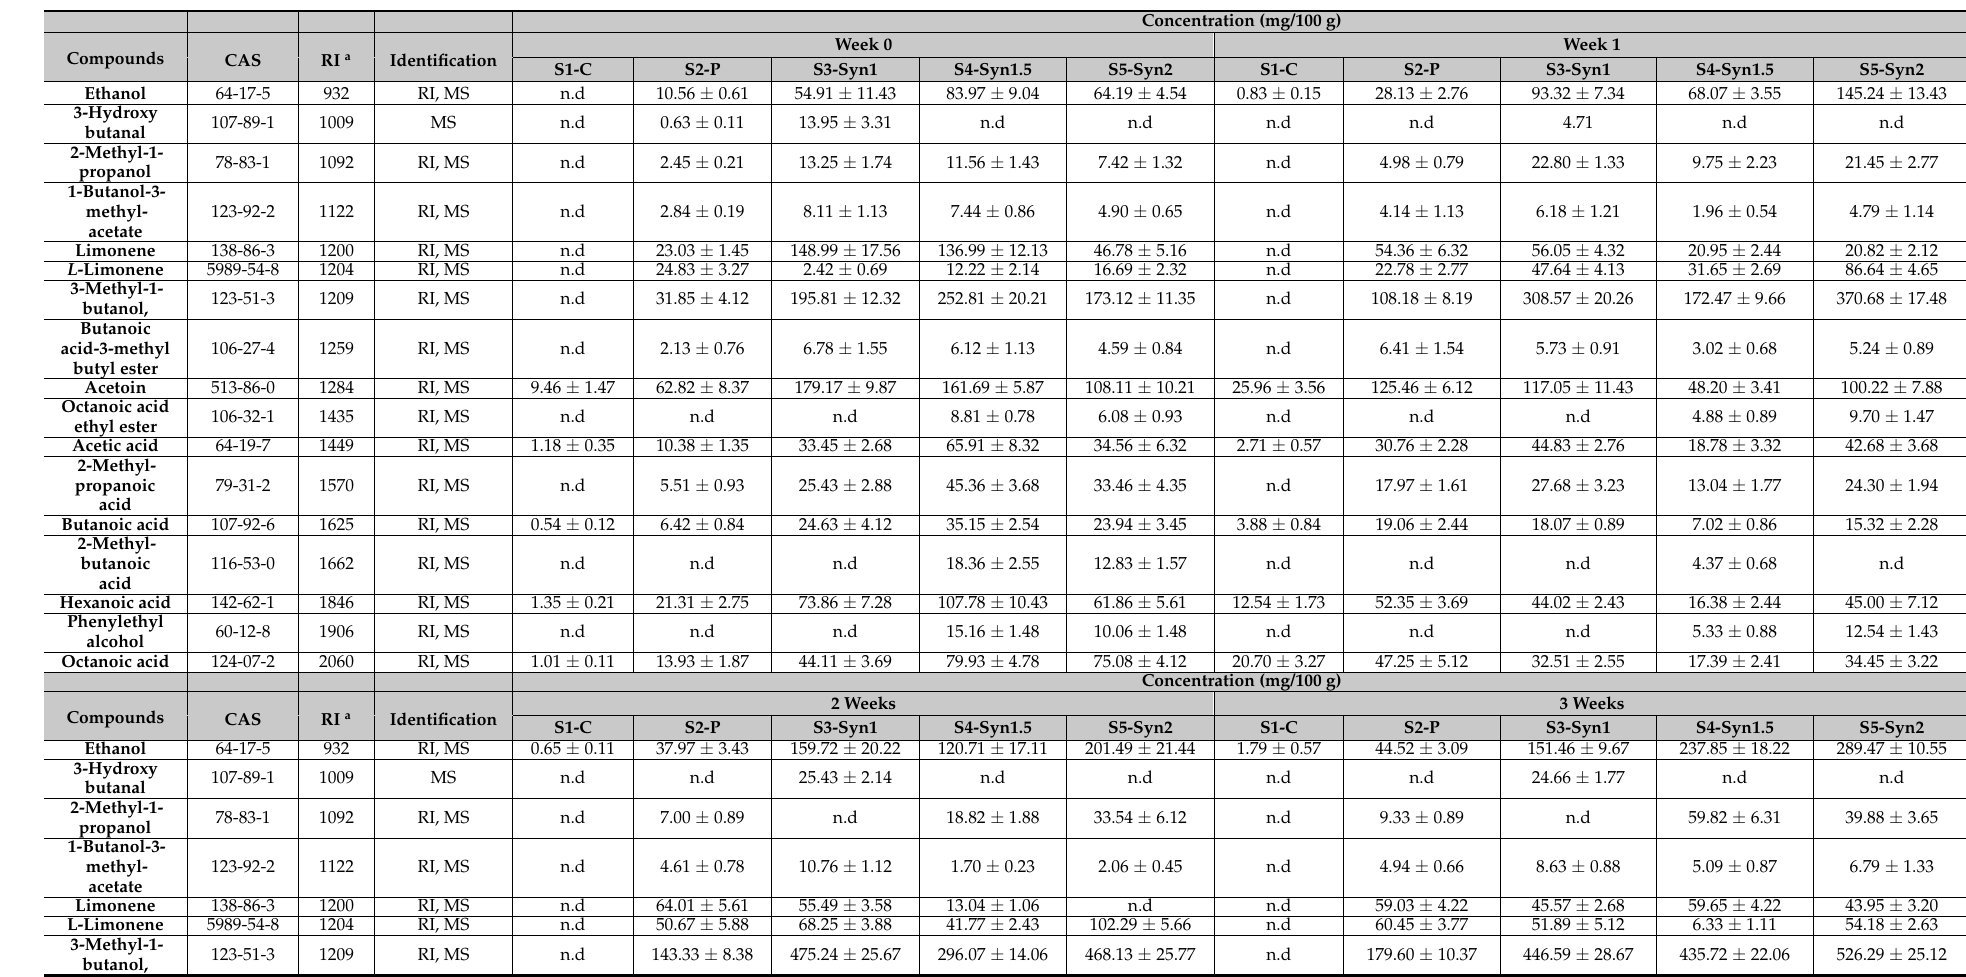
Table 4. Identification and quantitation of flavor-contributing volatile compounds in different yogurt samples during different times of